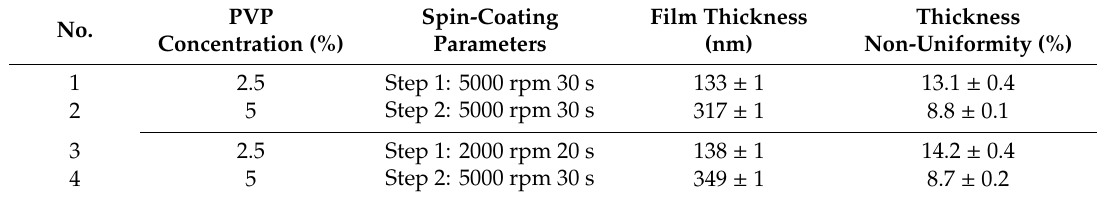
Table 3. Spin-coating conditions of PVP films, film thickness, and thickness non-uniformity.